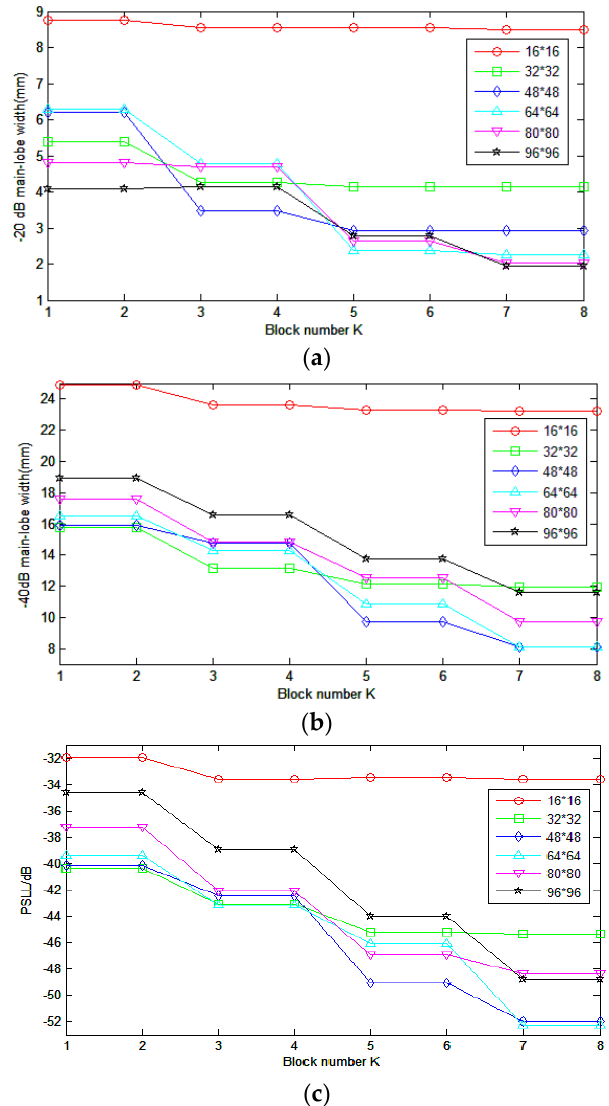
Figure 12. The changes of parameters for different arrays in signal channel direction. ( a – c ) represent the − 20 dB, − 40 dB main-lobe width and PSLL changed with split scheme from K = 1 to K = 8 respectively. Whereby K = 1 represents RCA array.